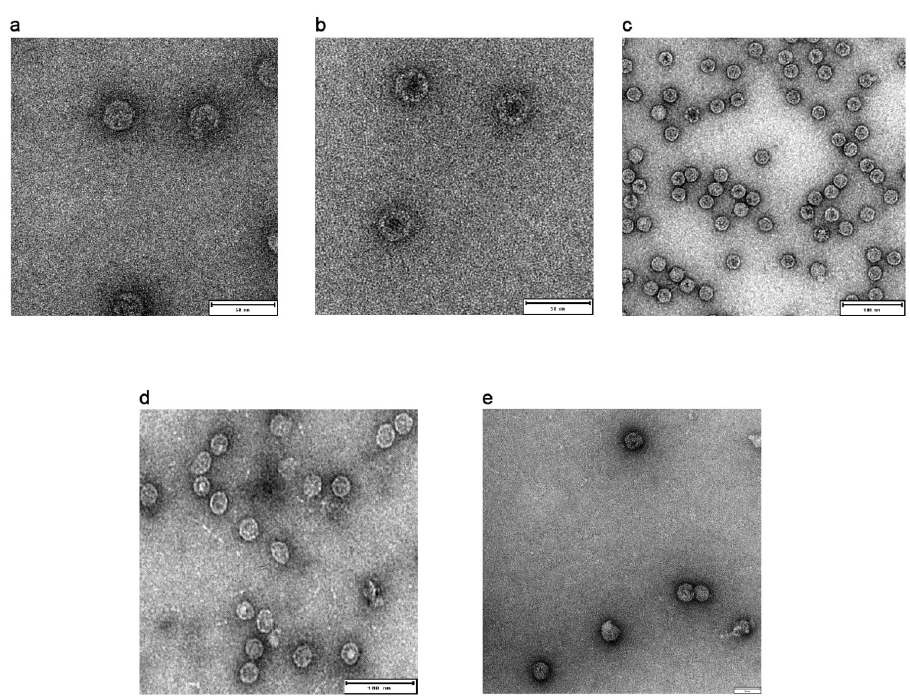
Fig 3. Negative staining transmission electron microscopy (NSTEM) of chimeric NPs displaying β barrel antigen after SEC purification. Properly assembled particles were detected for (A) β barrel-Ferritin with a diameter of 25nm (B) β barrel-mI3 with a diameter of 30nm (C) β barrel-Encapsulin presents a diameter of 30nm (D) β barrel-CP3 presents a diameter of 30nm (E) β barrel-HBcAg with a diameter of 35nm. Scale bars inserted in the pictures correspond to 50nm (A-B-E) and 100nm (C-D).